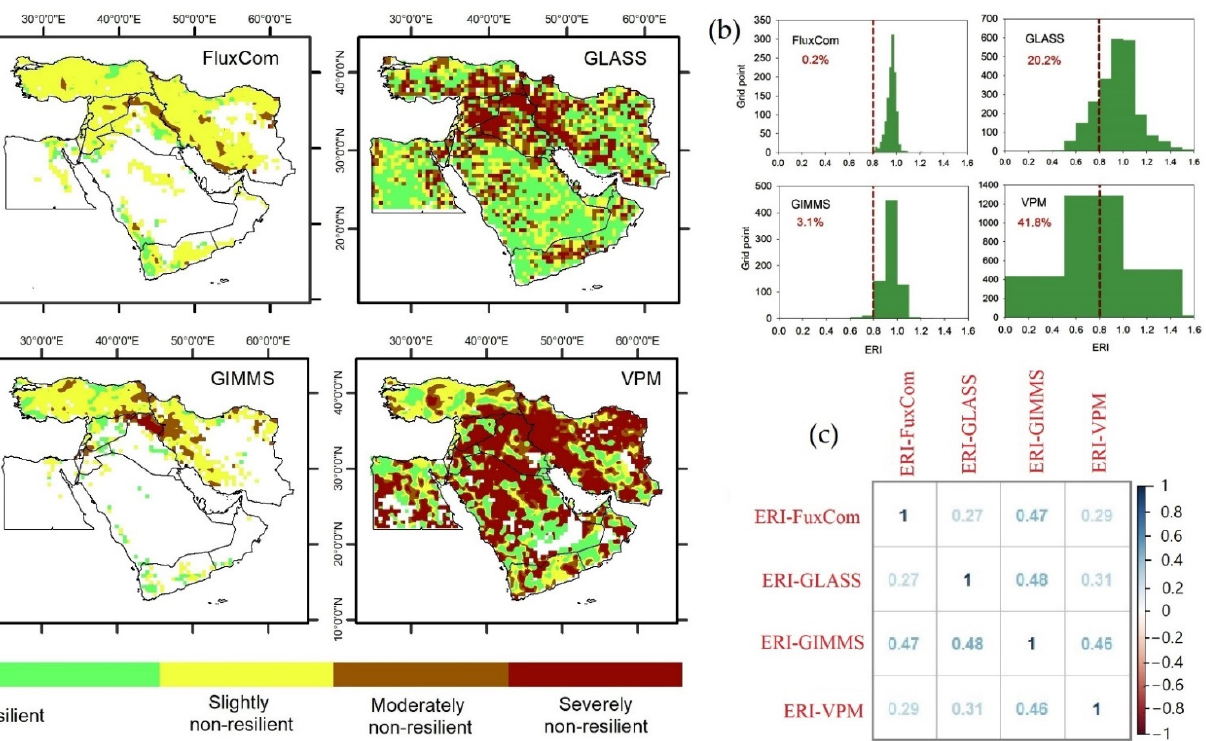
Figure 8. Spatial distribution of GLASS-GPP-based ERI values in the ME region from 1982 to 2016 based on land-cover data obtained from the SHARE dataset [50].